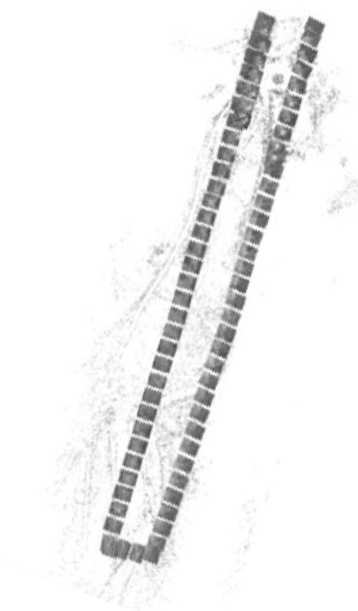
Figure 2. Outline of surveyed test areas on ©2014 Google Earth image